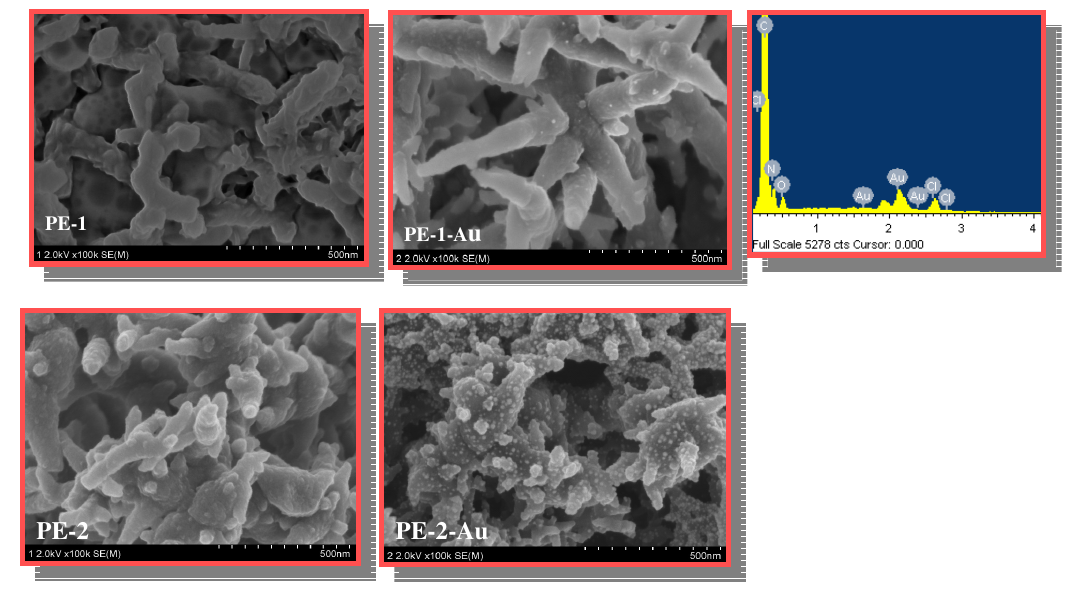
Figure 2. SEM images and EDX result of the PE-1, PE-1-Au, PE-2, electrodes (see, Scheme